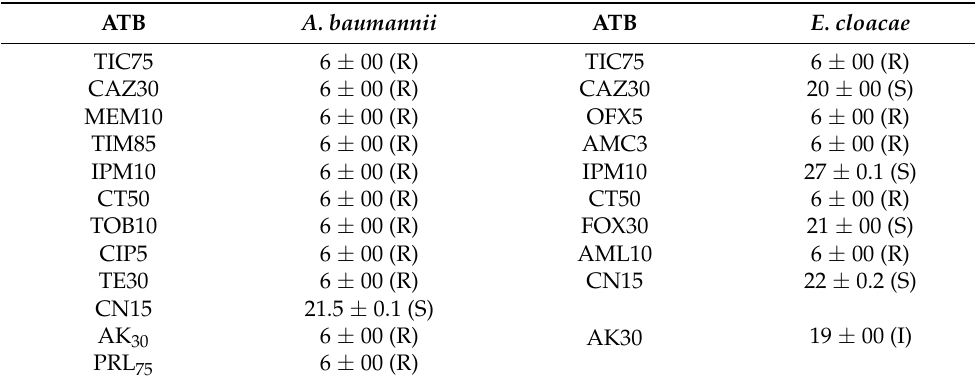
Table 4. Antibiotic sensitivity test for A. baumannii and E. cloacae .